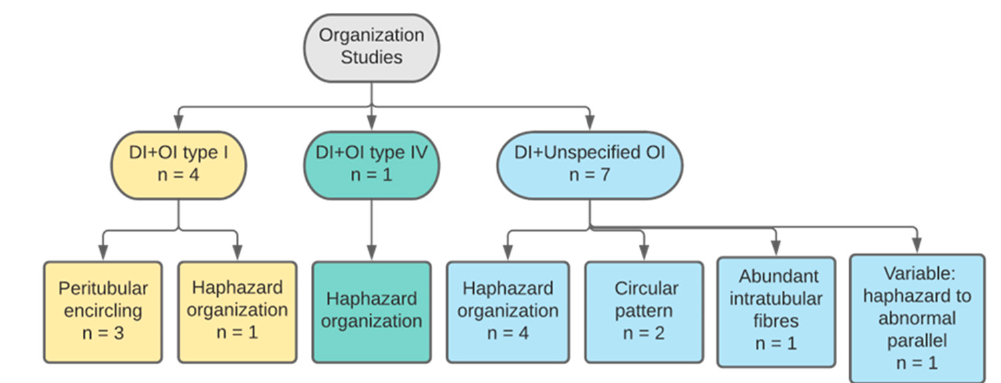
Figure 5. Categorisation of studies reporting on collagen organisation by DI and OI types.